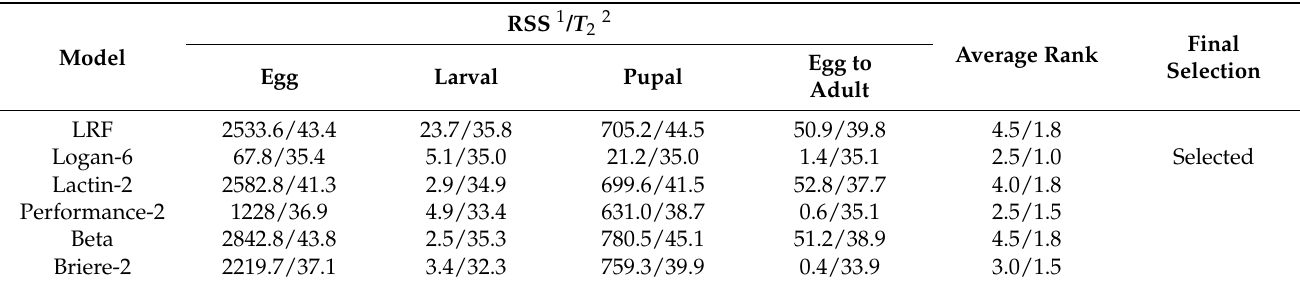
Table 3. Assessment of non-linear models based on the residual sum of squares (RSS) and conceptual upper development threshold ( T 2 ).